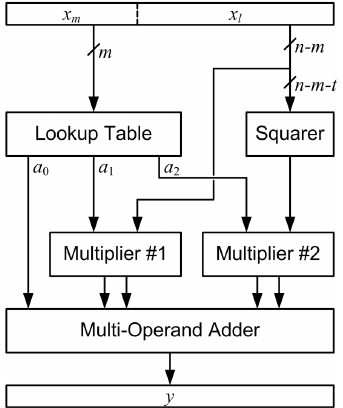
Figure 3. Quadratic interpolator block